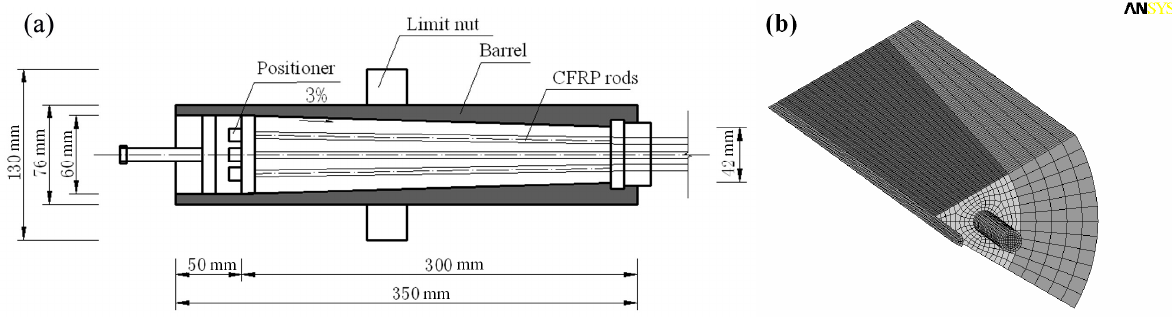
Figure 9. ( a ) Primary design of the inner cone bonding anchor; ( b ) 1/6 finite element